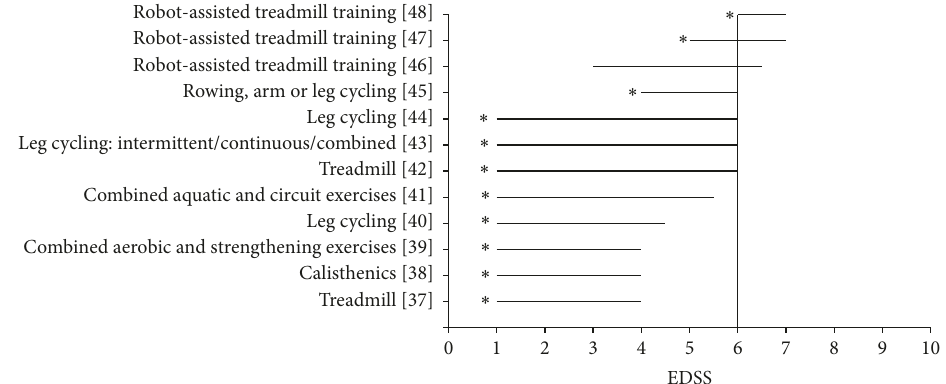
Figure 2: Aerobic interventions for varying disability levels. 𝑥 -axis: the Expanded Disability Status Scale (EDSS) score ranges from no disability (0) to death (10). At 6.0, patients use walking aids. 𝑦 -axis: the aerobic exercise interventions of experimental groups in the clinical studies included in this review. ∗ Statistically significant improvements on walking performance.